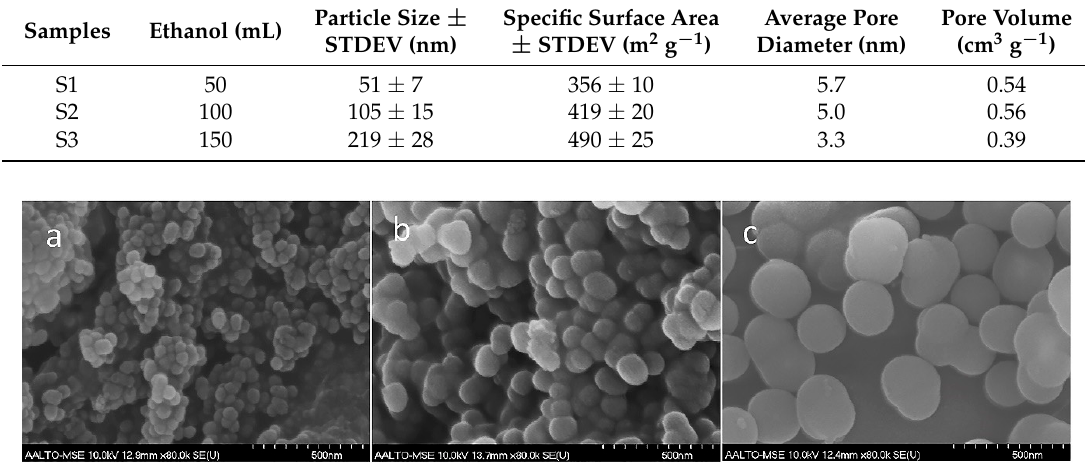
Table 1. The properties of dried samples prepared with different volumes of ethanol via a modified Stöber method (STDEV = standard deviation).